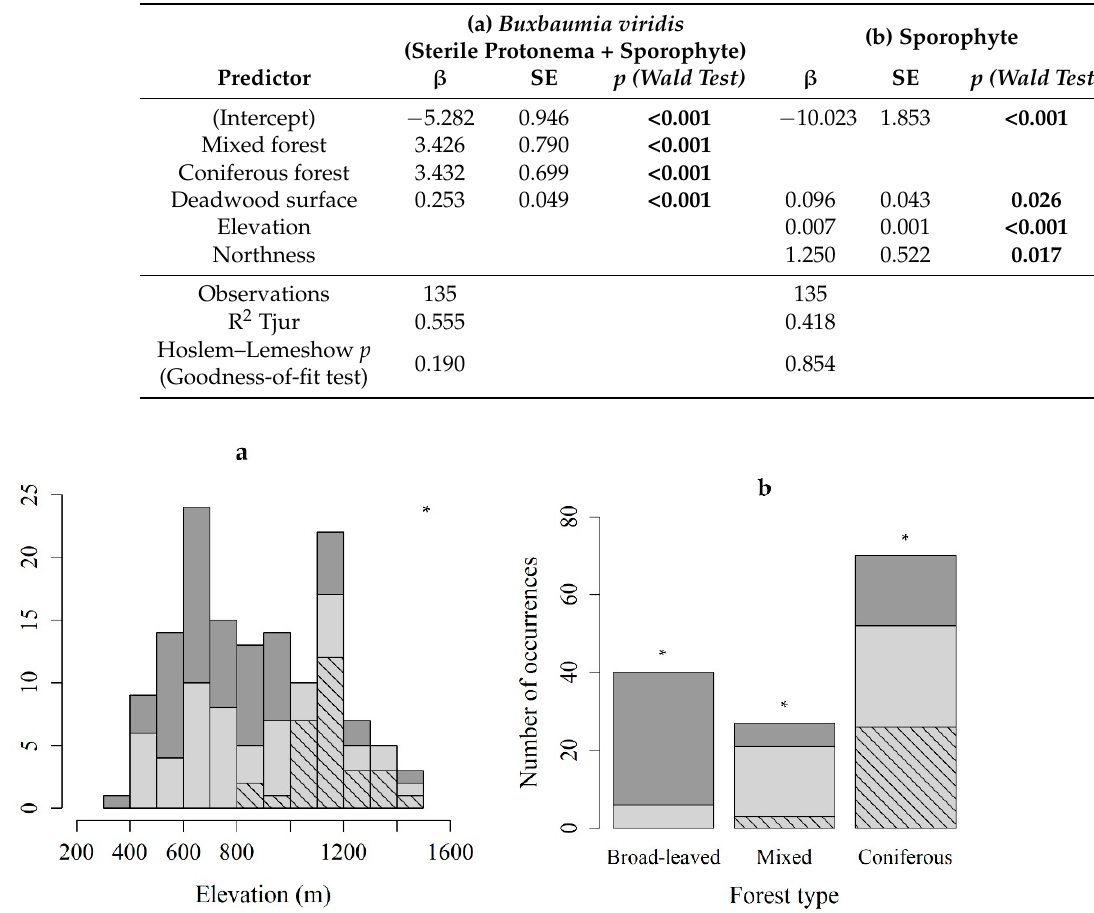
Figure 2. The number of occurrences of the protonemal stage of Buxbaumia viridis (light gray) and the sporophyte stage (hatched) classified by elevation ( a ) and forest type ( b ). Dark gray: total stands surveyed. The two variables were significantly different between habitats with sporophytes, and those with protonemal stage only (Kruskal–Wallis chi-squared = 9.7036, df = 1, p < 0.05 for elevation, and χ 2 test, p < 0.05 and absolute residual value >2 for forest type); * p ≤ 0.05.